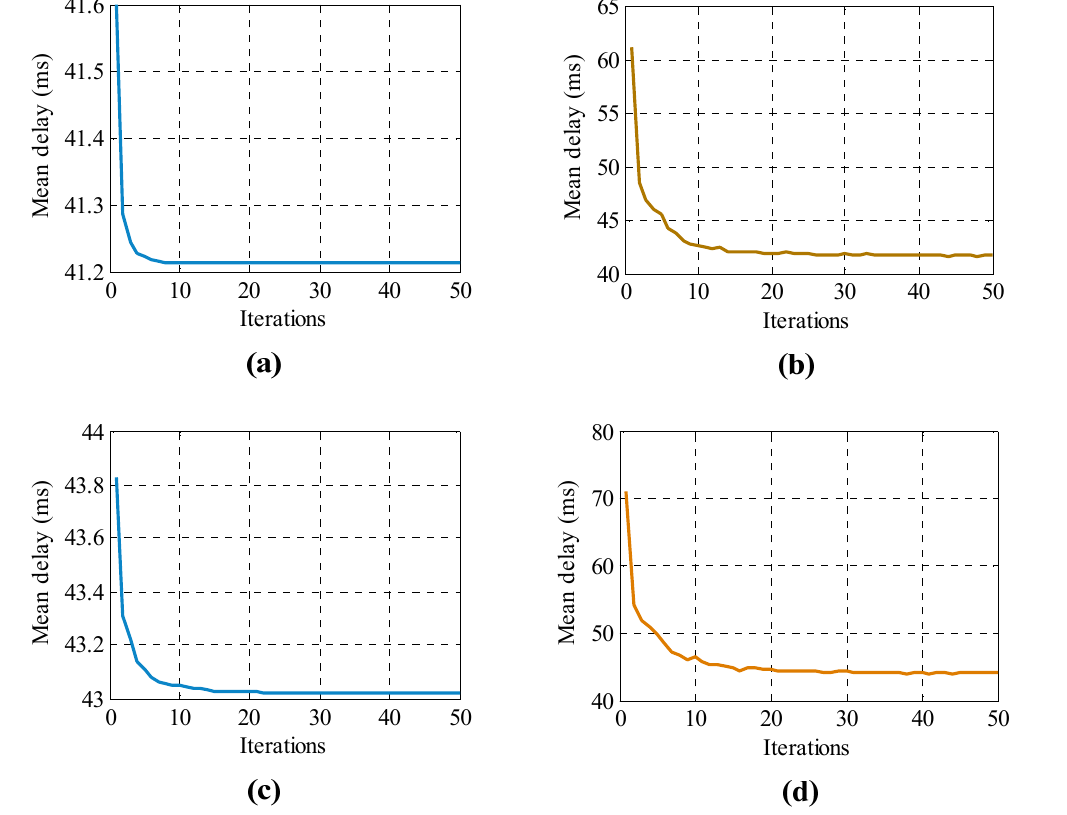
Figure 4. Convergence property of the algorithm averaged over 100 independent experiments. ( a ) Performance of the best particle of the swarm (time duration during which a channel remains vacant follows Uniform distribution). ( b ) Average performance of the whole swarm (time duration during which a channel remains vacant follows Uniform distribution). ( c ) Performance of the best particle of the swarm (time duration during which a channel remains vacant follows Exponential distribution). ( d ) Average performance of the whole swarm (time duration during which a channel remains vacant follows Exponential distribution).